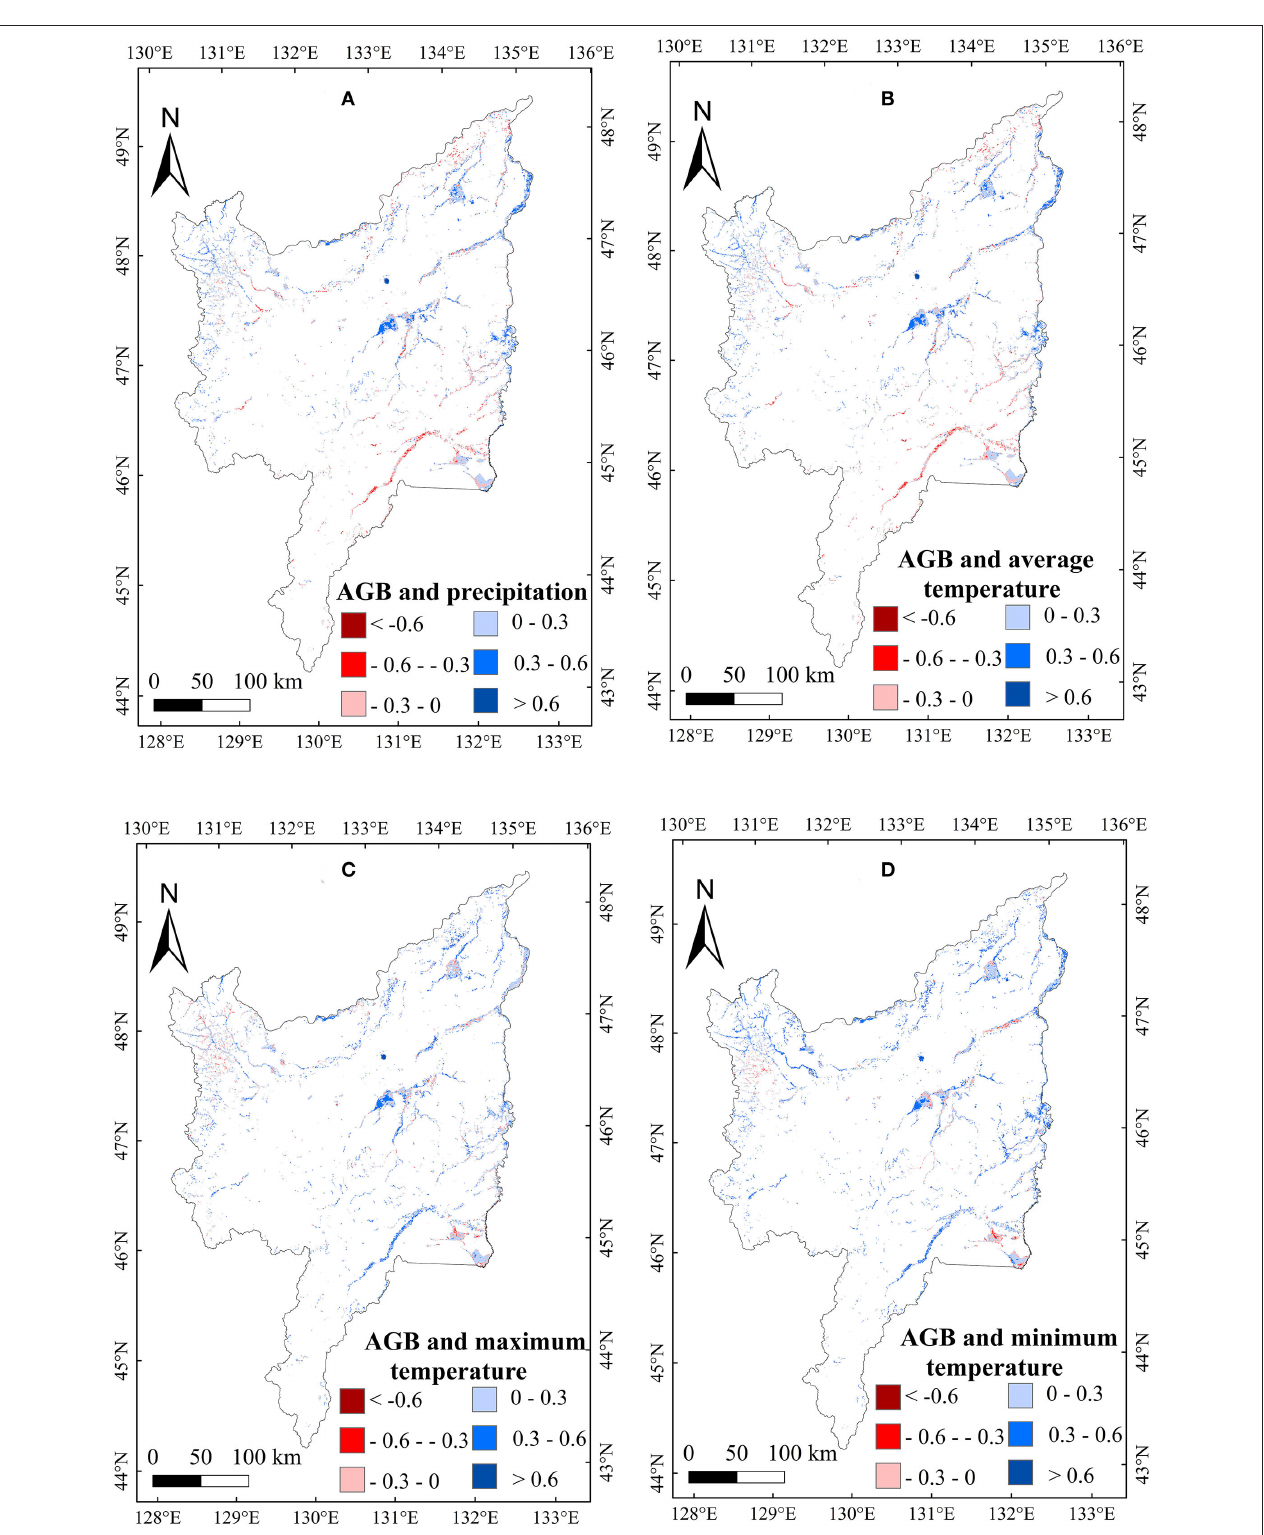
FIGURE 7 | Spatial patterns in relationships of AGB with precipitation (A) , mean temperature (T mean ) (B) , maximum temperature (T max ) (C) , and minimum temperature (T min ) (D) in July on the Sanjiang Plain marshes from 2000 to 2020.